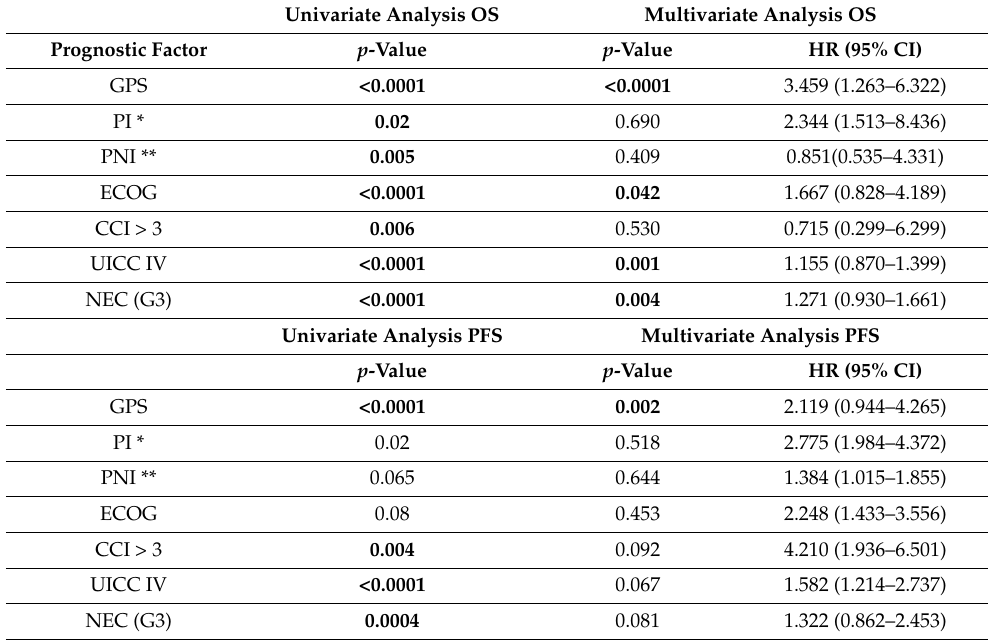
Table 5. Overall survival and progression-free survival in the univariate analysis and consecutive multivariate Cox proportional hazard